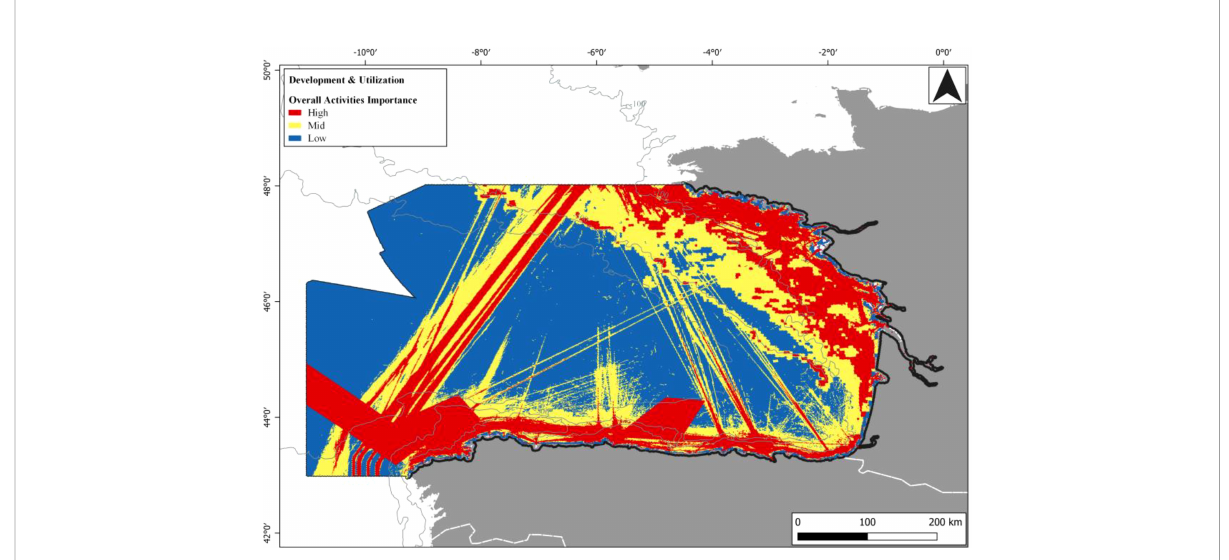
FIGURE 4 Aggregated assessment of the spatial distribution of important areas for human activities based on eight activities within the Bay of